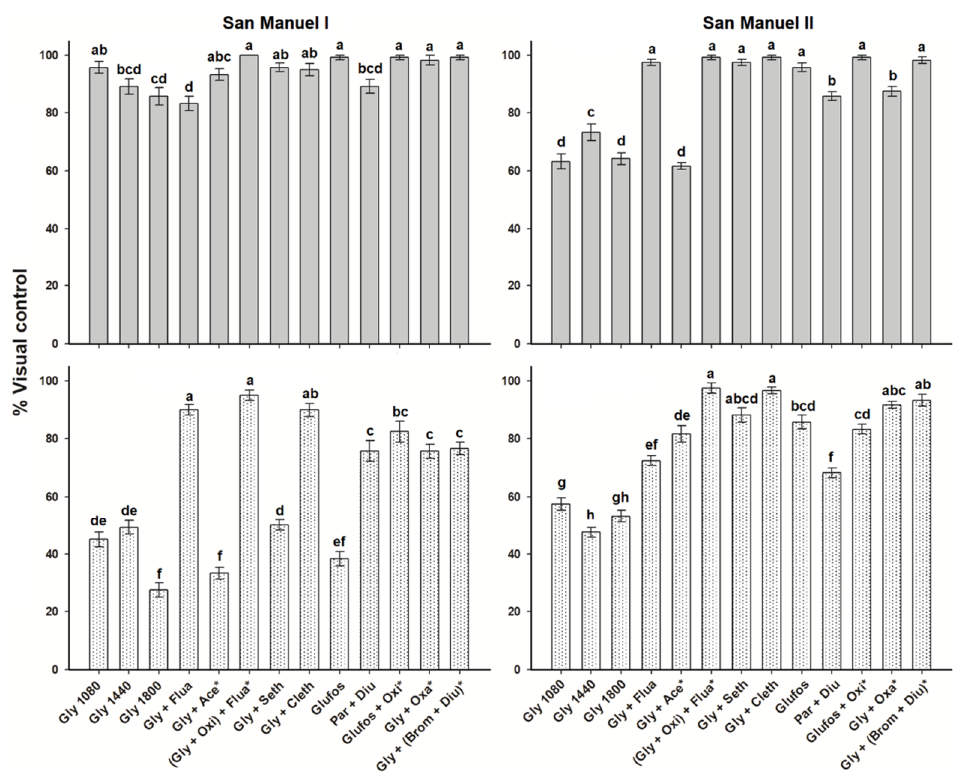
Figure 2. Control of Leptoclhoa virgata in two Persian lime groves of the “San Manuel” Farm, Puebla, Mexico, at 30 (gray bars) and 75 (dotted bars) d after treatment. Same letter within a subfigure showed no differences between treatments by the Tukey test ( P > 0.05). Vertical bars ± standard error from combined data of field trials carried out in 2014 and 2015 ( n = 6).